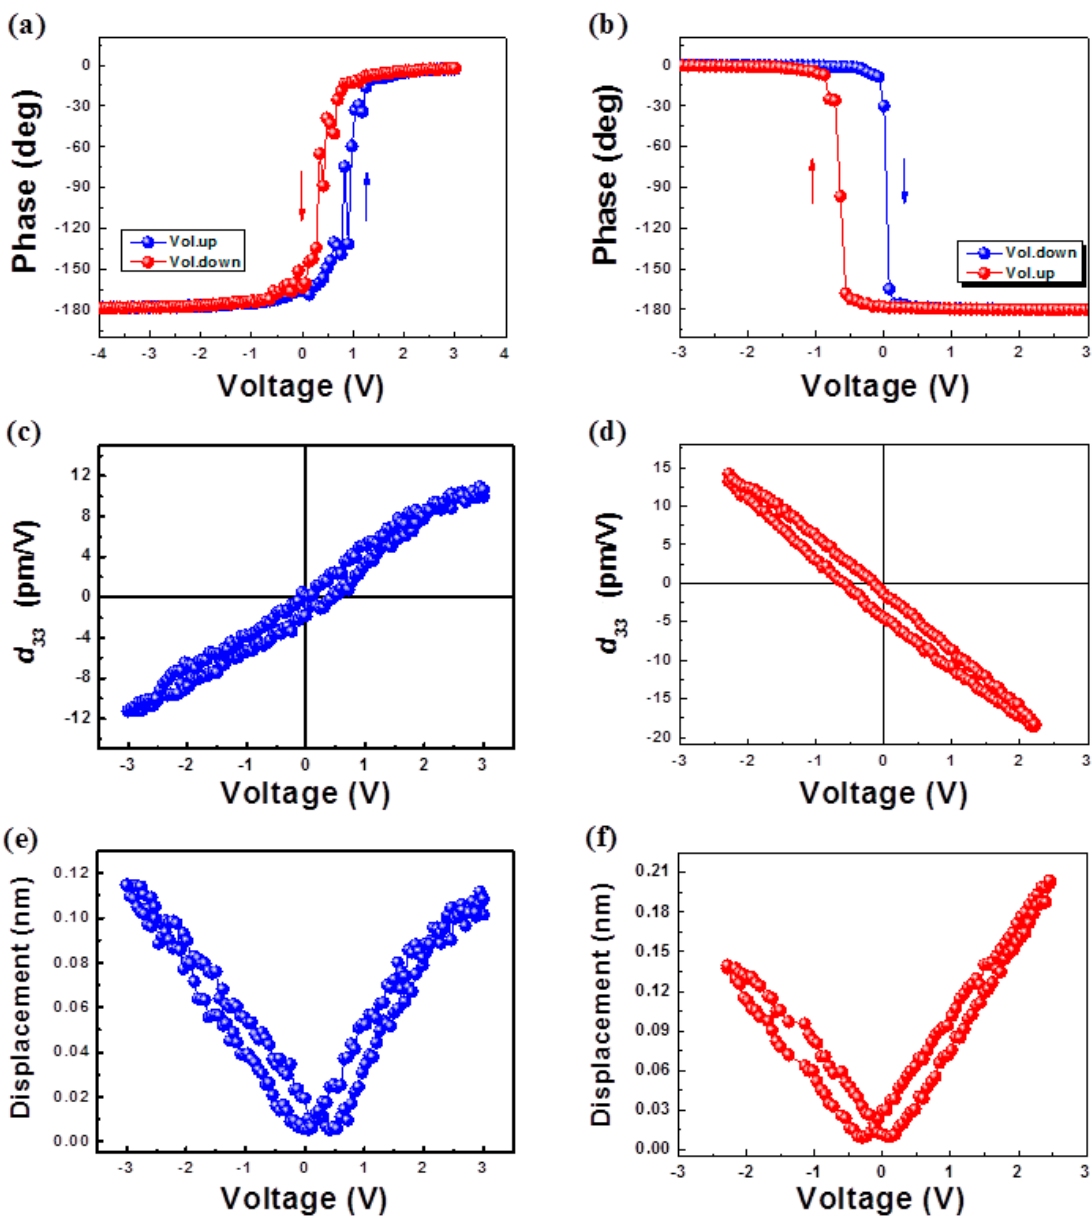
Figure 4. The hysteresis loop of the piezoelectric response for the ZnO films on (+z) LiNbO 3 and (-z) LiNbO 3 , respectively. The phase-hysteresis loop of the ZnO films on (+z) LiNbO 3 ( a ) and (-z) LiNbO 3 ( b ), respectively. The effective piezoelectric-coefficient ( d 33 ) loop of the ZnO films on (+z) LiNbO 3 ( c ) and (-z) LiNbO 3 ( d ), respectively. The D-V butterfly loop of the ZnO films on (+z) LiNbO 3 ( e ) and (-z) LiNbO 3 ( f ), respectively.